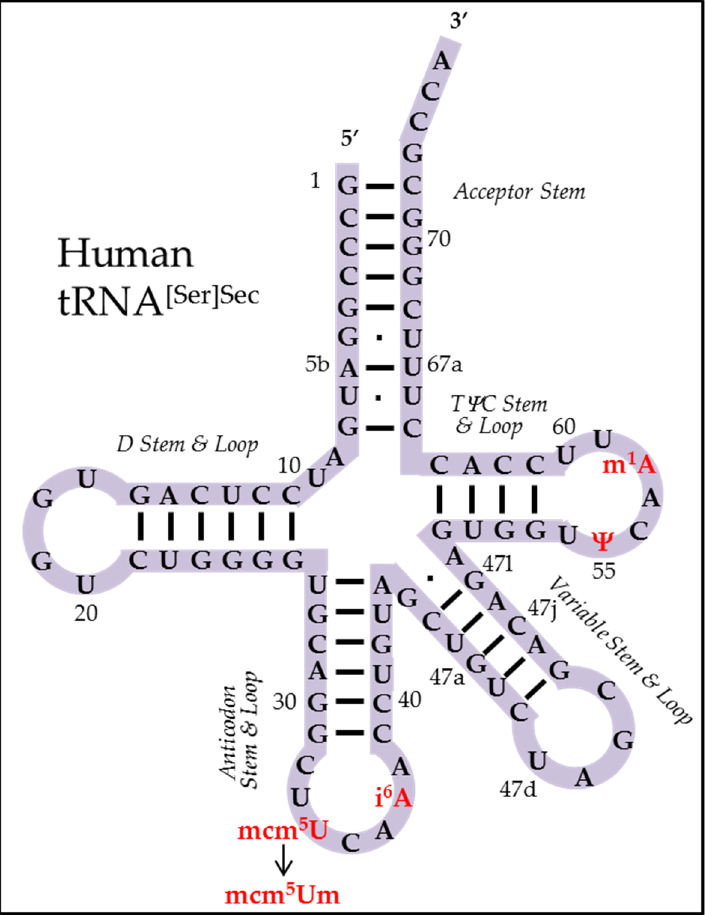
Figure 1. Cloverleaf model of human tRNA[Ser] Sec . The image shows the 90 bases in human tRNA[Ser] Sec . The paired 5 ′ and 3 ′ terminal bases constitute the acceptor stem, and on the left portion of the tRNA, the D stem and loop constitute six paired and four unpaired bases. On the lower portion of the tRNA, the anticodon stem and loop constitute six paired and seven unpaired bases, and the variable stem and loop constitute five paired and four unpaired bases. On the right portion of the tRNA, the T Ψ C stem and loop constitute four paired and seven unpaired bases. Human tRNA[Ser] Sec contains base modifications at the following positions: 34 (mcm 5 U), 37 (i 6 A), 55 ( Ψ ), and 58 (m 1 A). The two isoforms differ from one another at position 34 by a single methyl group on the 2 ′ -O-ribosyl moiety.